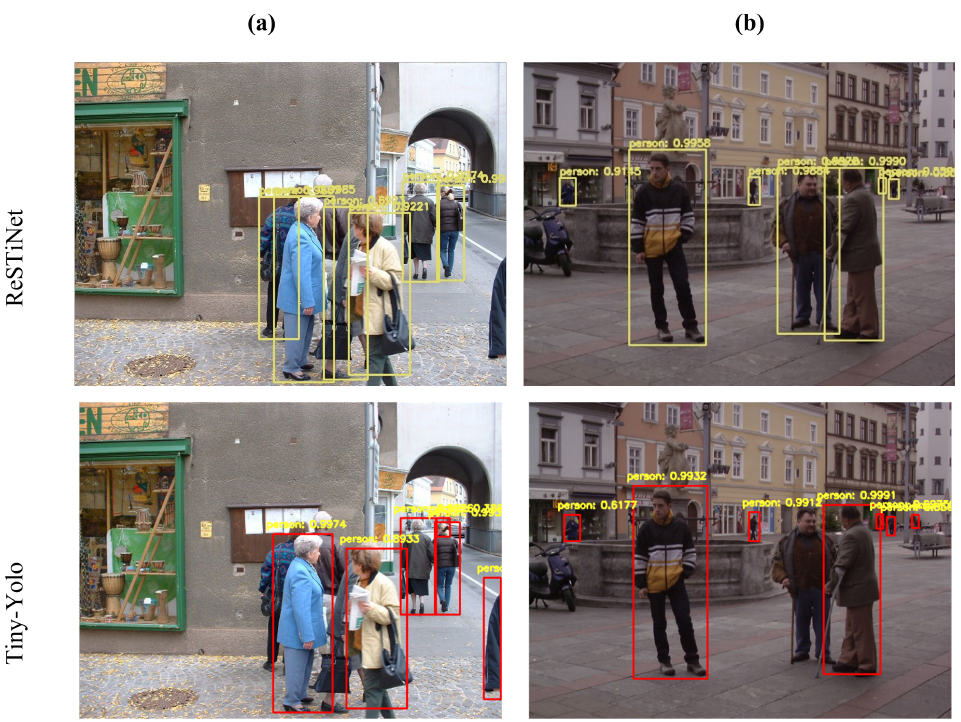
Figure 7. Detection results with confidence values for proposed ReSTiNet and Tiny-YOLO model in a dense scenario. ( a , b ) presents comparison for two images for the